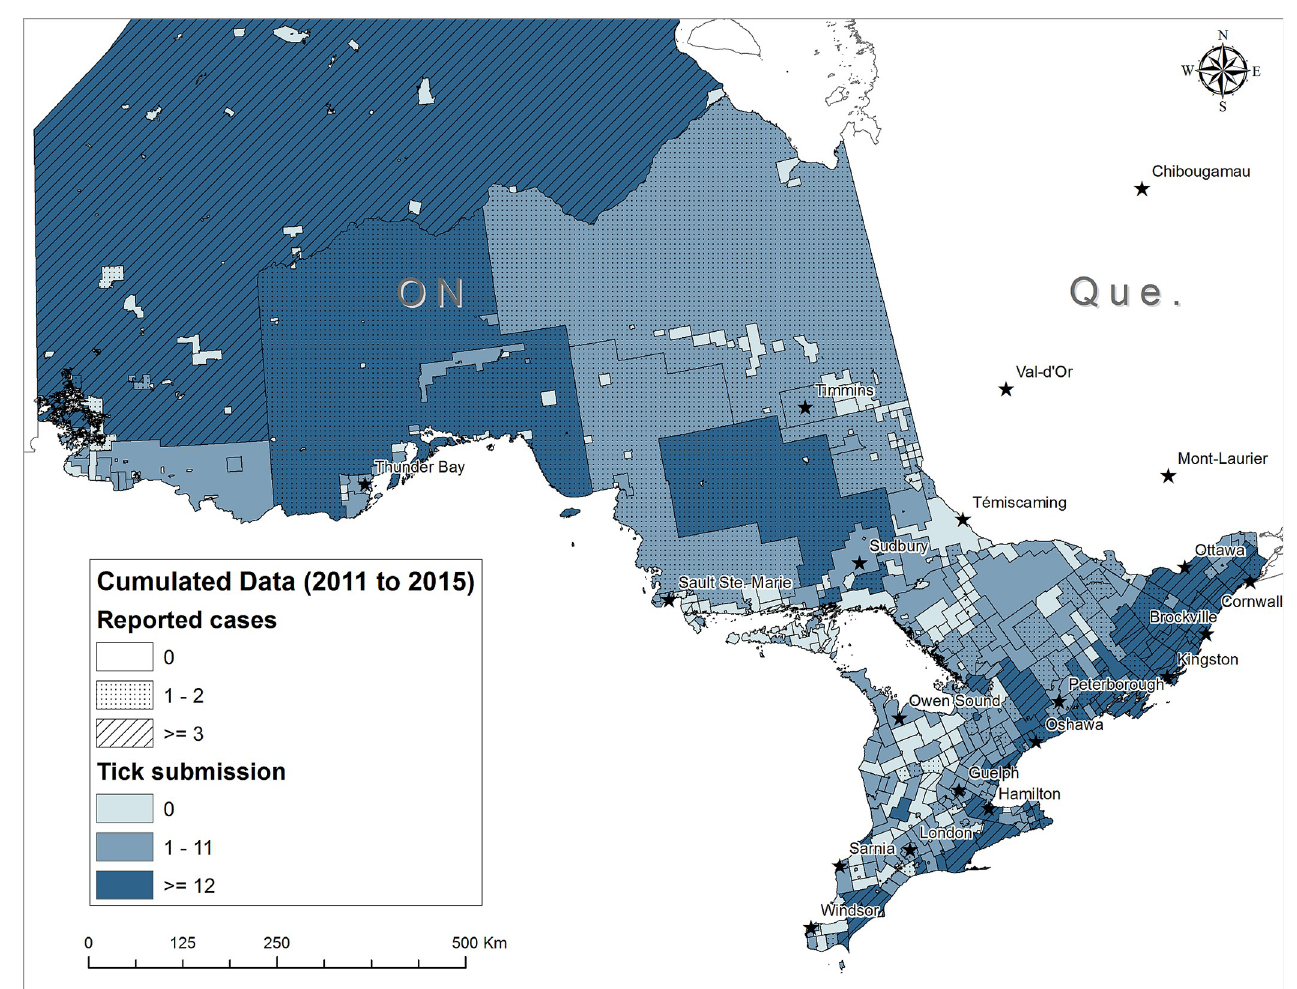
Fig 3. Geographic distribution of passive I . scapularis tick submissions (adults and nymphs) and total number of reported human Lyme disease cases in CSDs in Ontario from 2011 to 2015. Dotted CSDs are areas with emerging risk (1–2 human Lyme disease cases). Hatched CSDs are endemic areas where � 3 Lyme disease cases were acquired. Light blue CSDs are areas where the number of adult and nymphal is < 12, the optimal cut-off point as indicator of the human Lyme disease risk. Dark blue CSDs are areas where the number of I . scapularis submissions is � 12.